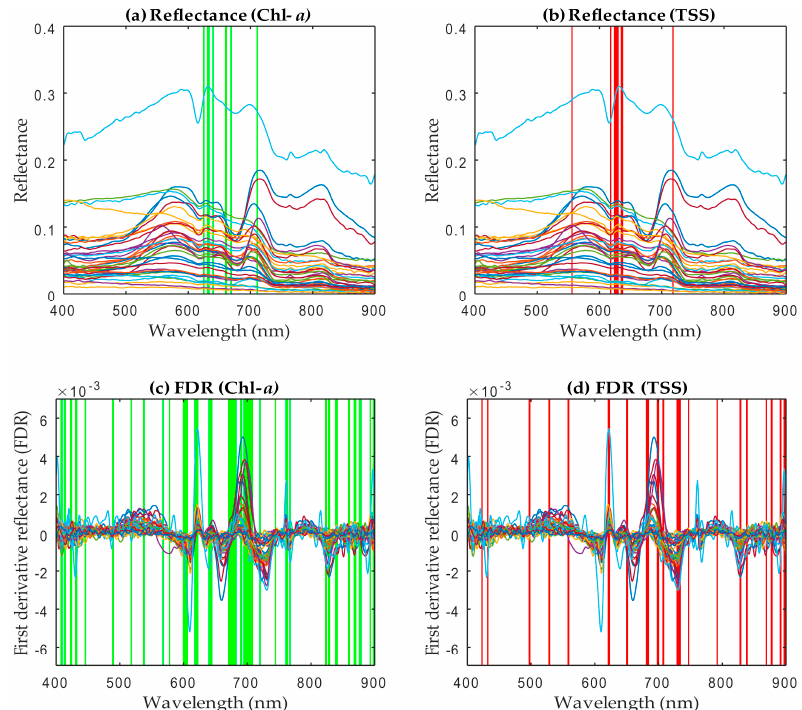
Figure 5. Selected wavebands in ISE–PLS using reflectance or FDR datasets ( n = 36) to estimate: ( a ) and ( c ) Chl- a ; ( b ) and ( d ) TSS. Green bars = Chl- a ; red bars = TSS.